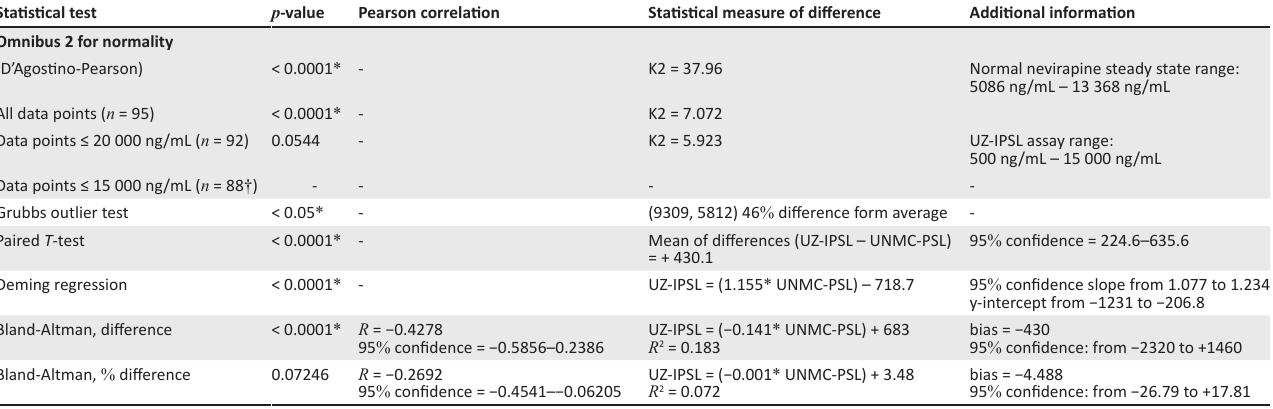
TABLE 1: A comparative study of nevirapine assay results conducted at the University of Zimbabwe International HIV Pharmacology Specialty Laboratory (Harare, Zimbabwe, May 2018) and the University of Nebraska Medical Center Pharmacology Specialty Laboratory (Omaha, Nebraska, United States, October, 2017). Statistical test p -value Pearson correlation